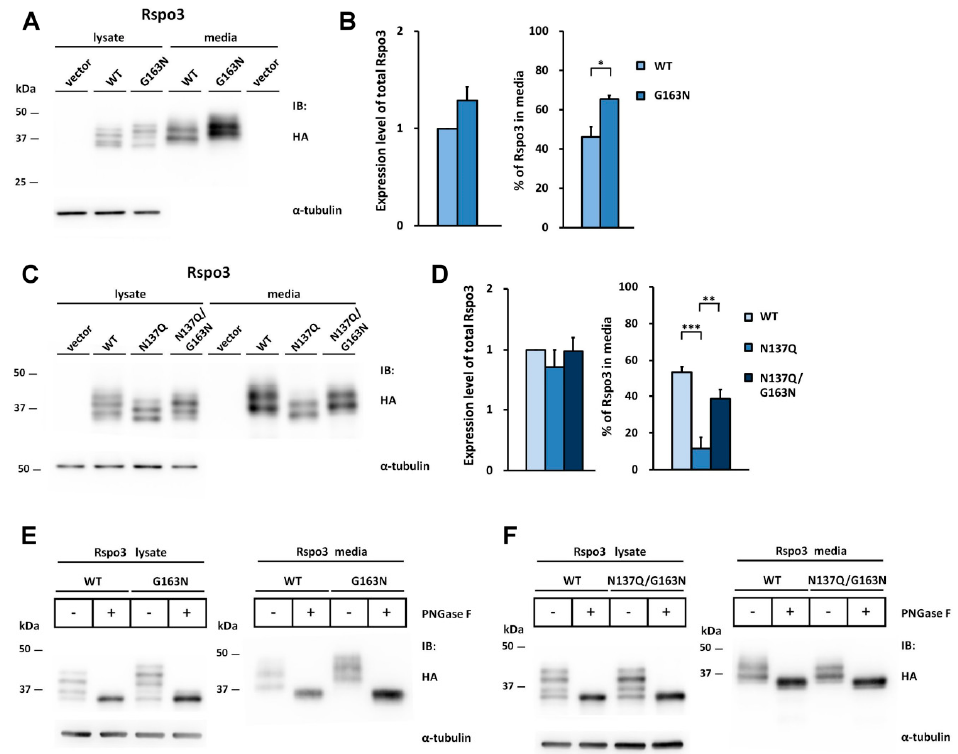
Figure 7. Introduction of the Rspo2 N-glycosylation site rescues the secretion defect of nonglycosylated human Rspo3 mutant. The Asn163-Lys164-Thr165 sequon (the position homologous to N160 in Rspo2) was constructed by mutation G163N in the WT or nonglycosylated human N137Q Rspo3 mutant. ( A , C ) Cell lysates or conditioned media from control vector or HA-tagged human Rspo3-transfected HEK293T cells were analyzed for the expression of HA-tagged human Rspo3. α -tubulin was used as a loading control for the cell lysates; ( B , D ) Quantification of total expression levels and percentage of Rspo3 in media for human WT Rspo3 versus the indicated mutants are shown. Immunoblots were quantified densitometrically and percentage of Rspo3 in media was calculated as described previously. Error bars represent the mean ± SD. All experiments were performed in triplicate. The Student’s t -test was used to evaluate statistical significance (* p < 0.05; ** p < 0.01; *** p < 0.001); ( E , F ) Cell lysates and conditioned media from WT, G163N or N137Q/G163N mutant Rspo3-transfected cells were digested with PNGase